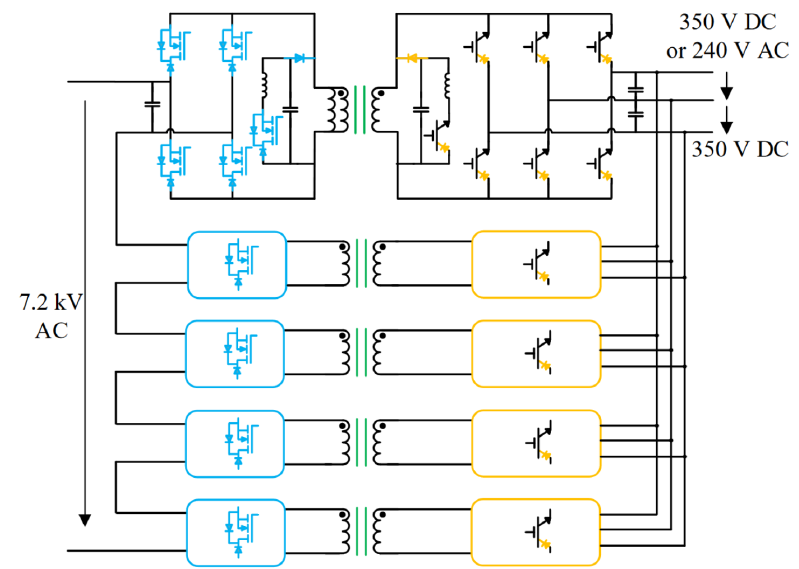
Figure 10. Modular S4T arrangement, configured for AC/DC operation [41].